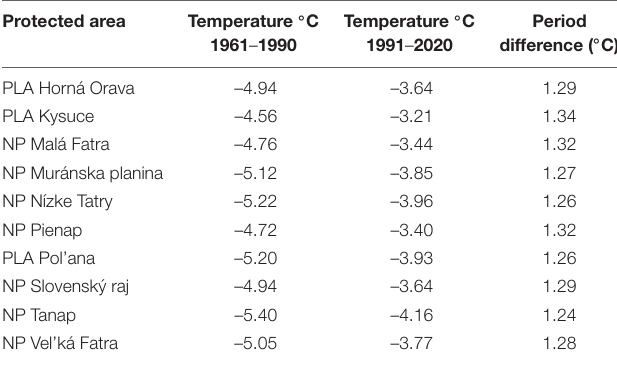
TABLE 5 | Mean January air temperature and its change in protected areas in both